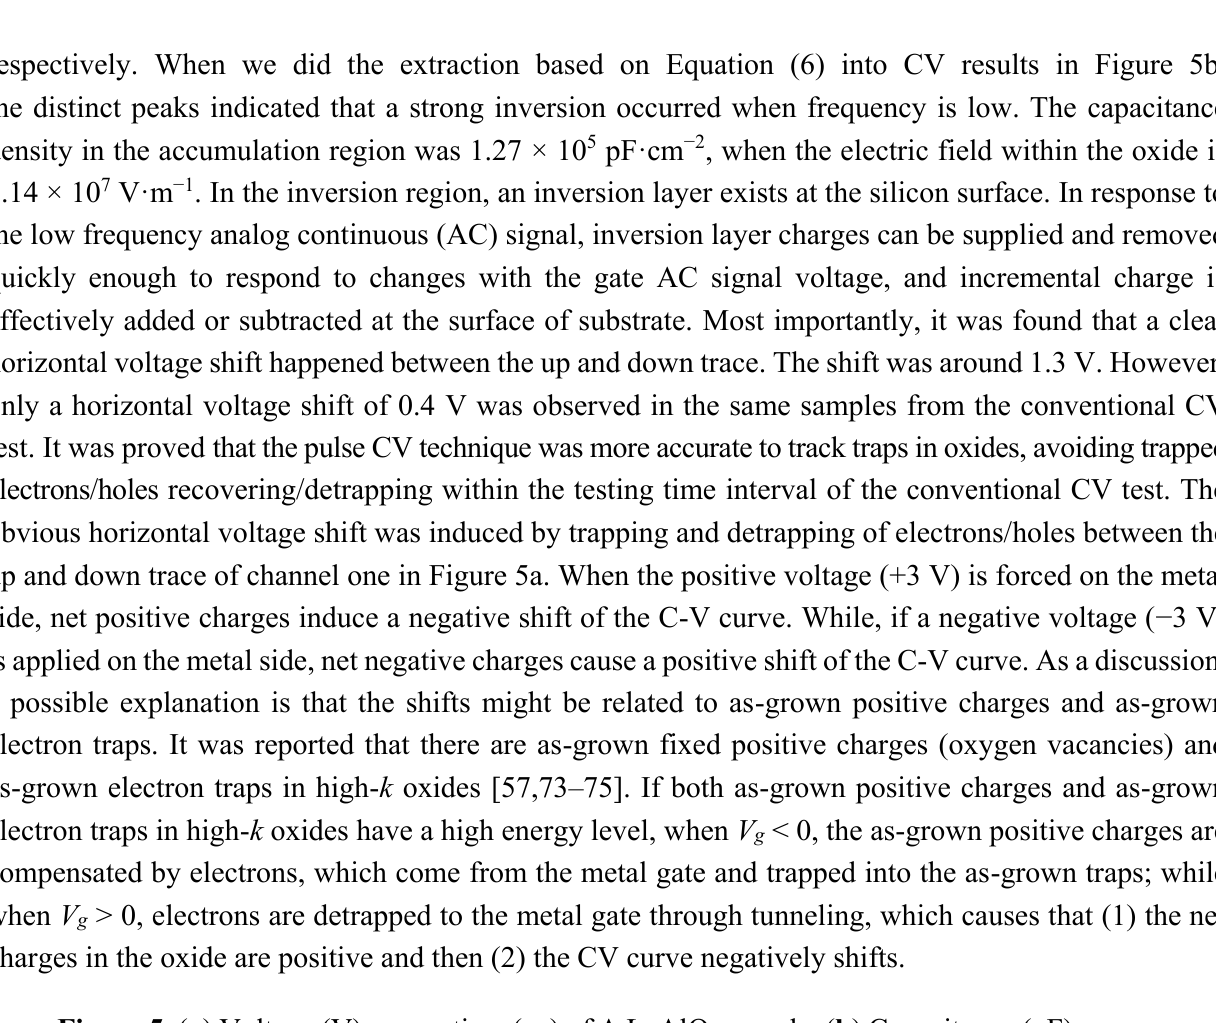
Figure 5. ( a ) Voltage (V) versus time (μs) of A LaAlO 3 sample. ( b ) Capacitance (pF) versus voltage (V) of the LaAlO 3 sample. In the pulse CV test, considerable flat-band voltage shift was